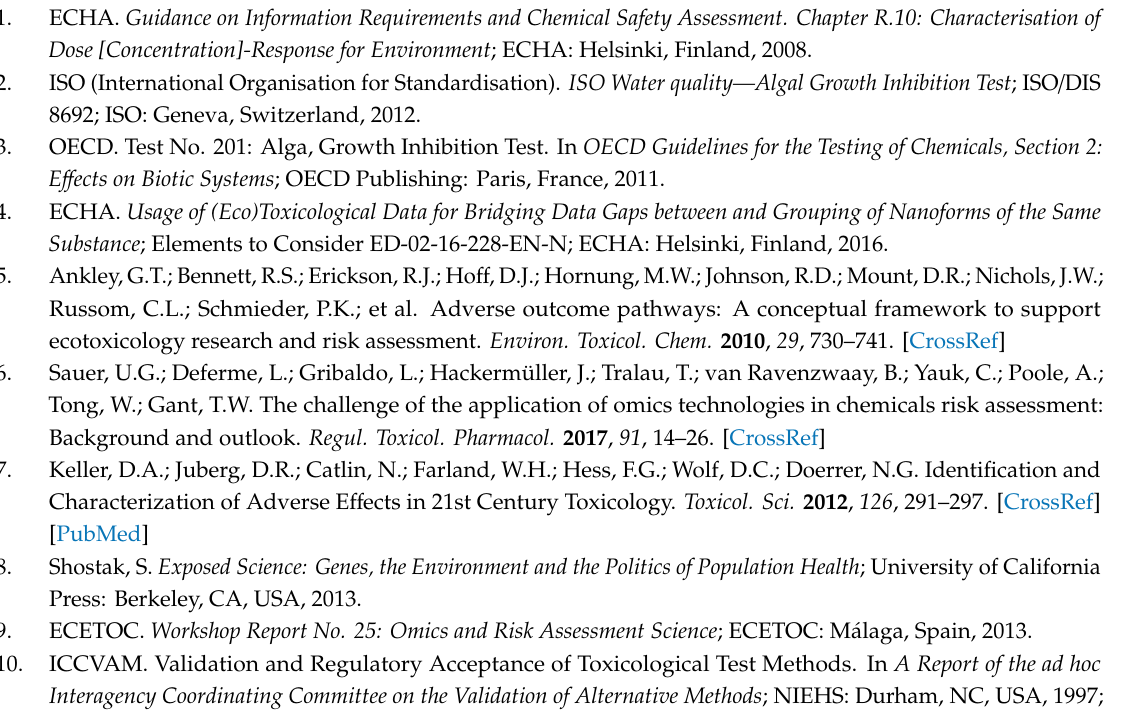
Figure S1: Metabolic fingerprints for pellet wash optimisation, Table S1: Unique m / z features in direct infusion mass spectra in dilution study, Figure S2: Growth rates and pH drift over 24 h growth of synchronised C. reinhardtii in CGM medium, Figure S3: Dose-response curve of 3,5-dichlorophenol, Figure S4: Relative standard deviation of m / z features per group between three independent repeated exposure studies, Figure S5: PCA scores plots (PC1 vs. PC3) visualising the similarities and di ff erences between three independent repeated exposure